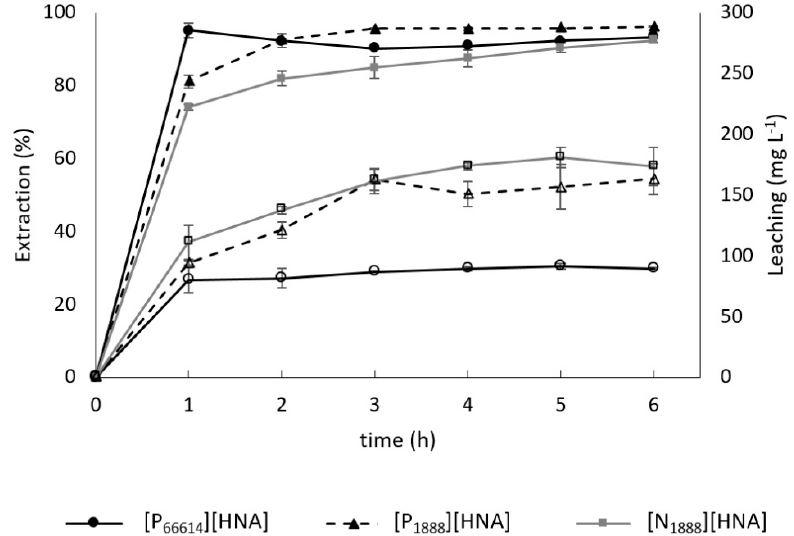
Figure 1. Time-dependent Hg extraction (filled symbols) from a pure water feed solution at pH 3.5 containing 1 mg L − 1 Hg and leaching of the ILs into the aqueous phase (open symbols); n = 3, error bars = ± standard deviation (SD).